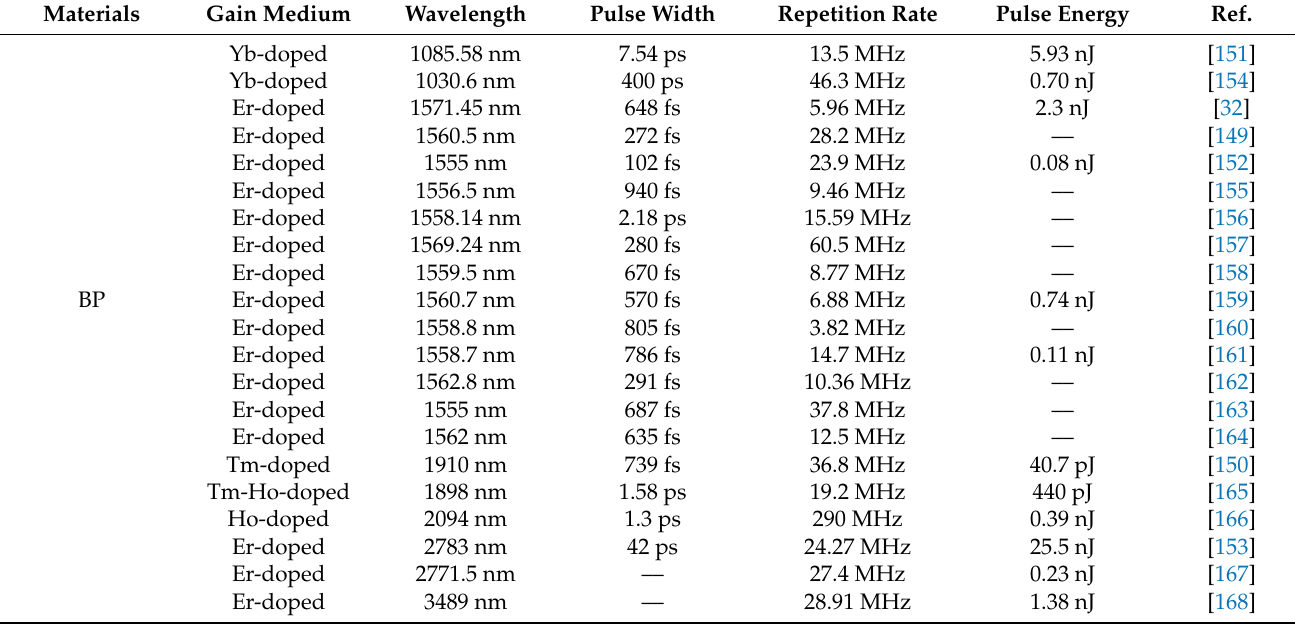
Table 5. Summary of passively mode-locked fiber lasers with BP